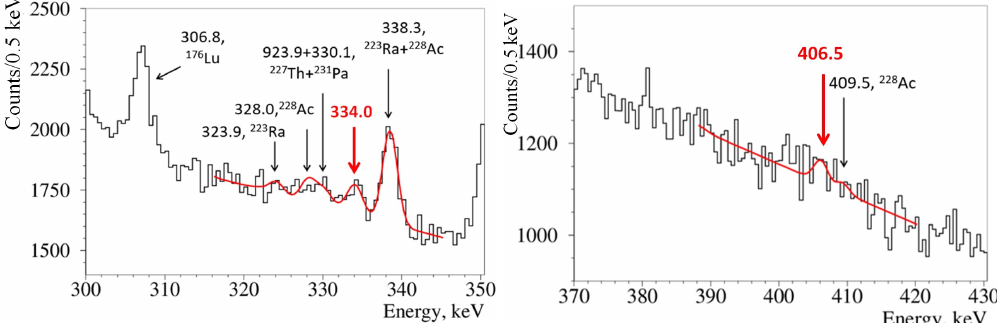
Figure 10. Spectra collected over 34,174 h by measuring Nd 2 O 3 powder in the four HP-Ge detectors (GeMulti) at STELLA facility of LNGS. The two plots refer to the regions of interest to search for de-excitation gamma of the 0 + level of 150 Sm 1